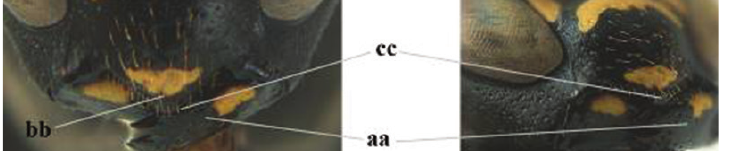
– Mandible comparatively slender and its outer face weakly convex or flat (aa); ventral border of clypeus flat (bb) and medially truncate or slightly concave (cc); social species .......................................................................................